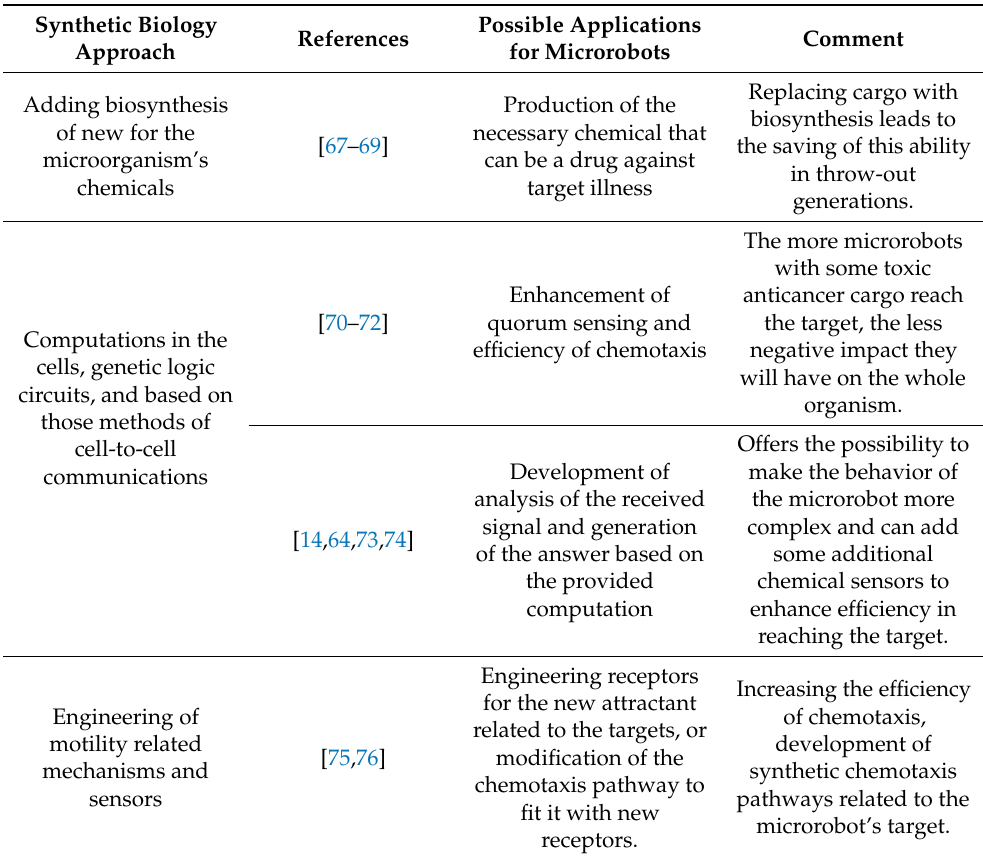
Table 2. Synthetic biology approaches that can be considered for application in a microbial cell-based microrobot